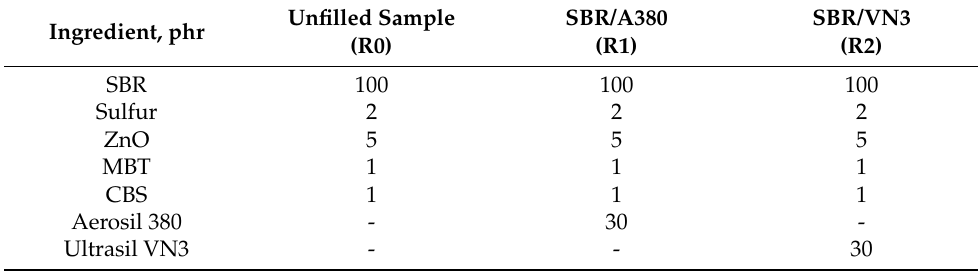
Table 2. General recipes of styrene–butadiene rubber (SBR) reference compounds, parts per